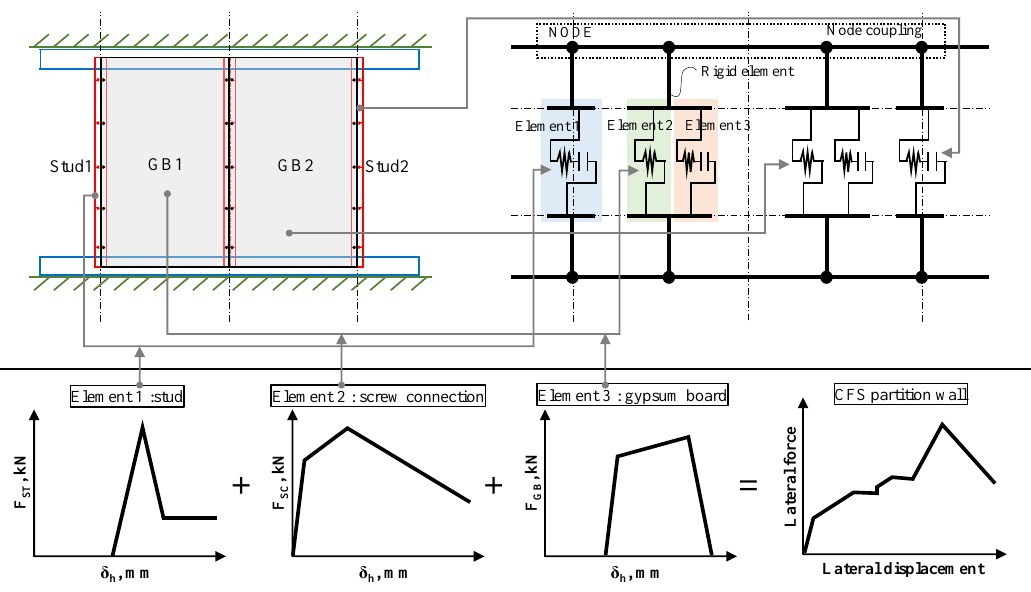
Figure 7. Schematization of the modelling approach for the CFS partition wall.